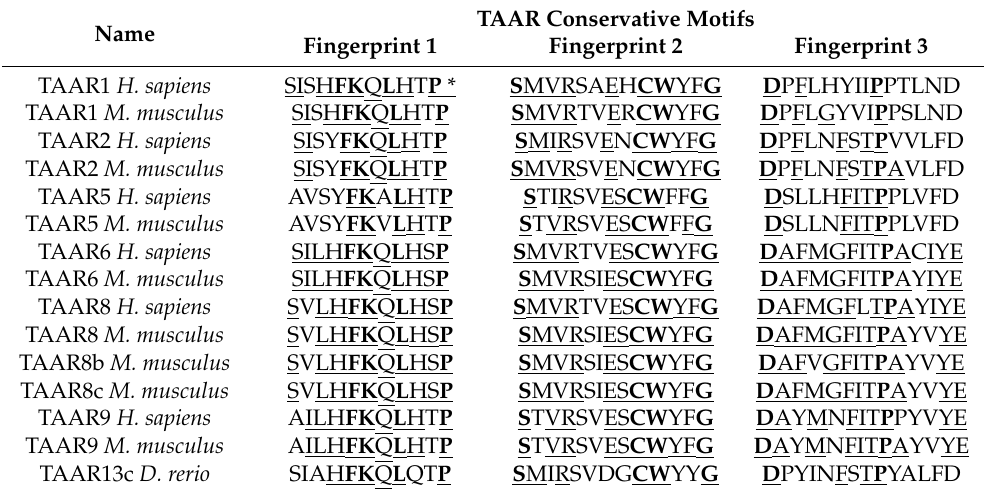
Figure 1. Comparison of amino acid sequences of mouse, human, and fish TAAR proteins. The group of conservative motifs (fingerprints) is highlighted in purple, and the motive that determines belonging to the rhodopsin family, predicted using the PRINTS Database program, is highlighted in blue. Conserved residues of aspartic (Asp 2.50 , Asp 3.32 , Asp 3.49 , Asp 5.42 , Asp 6.59 , Asp 7.37 ) and glutamic (Glu95) acids were noted. In addition, the numbering of cysteine residues is given for the TAAR6 protein. Table 1. Group of TAAR conservative motifs (fingerprint) of humans, mouse, and fish.